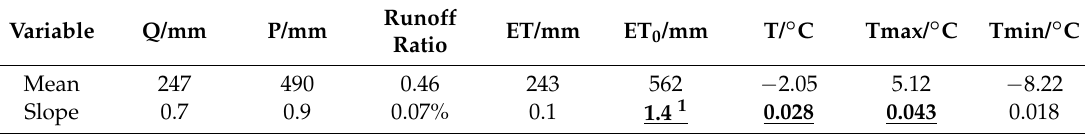
Table 3. Hydrological and climatic changes for study